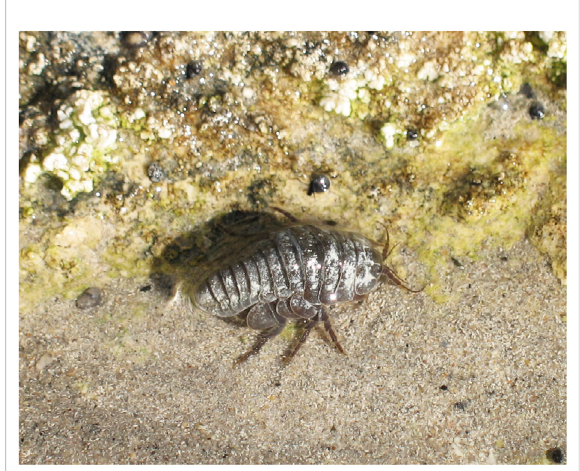
FIGURE 5 The isopod Phreatomerus latipes , a species endemic to the SA GAB springs that might represent a localized, if not species- wide, extinction asa result ofthedegradationofsprings via threats detailed in this review. Photo credit Rachael